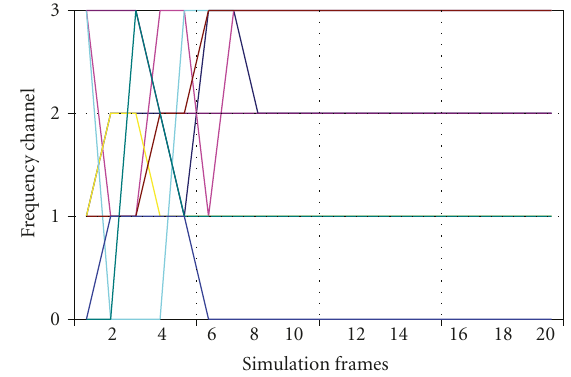
Figure 4: Convergence of SUs pairs–frequency